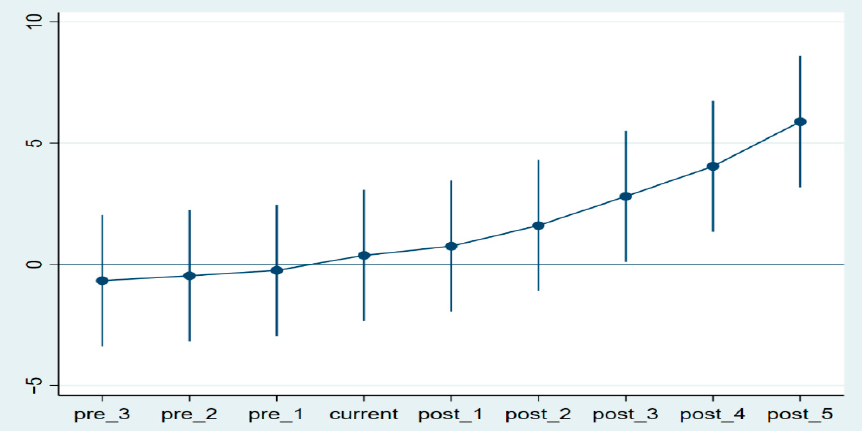
Figure 1. Parallel trend test chart.